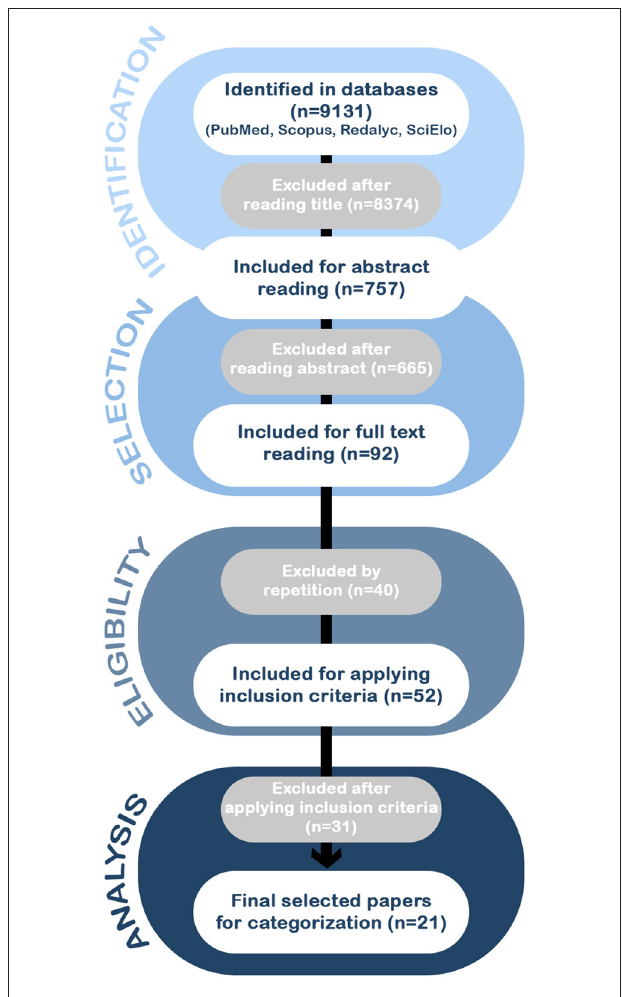
FIGURE 1 | The flow of information through the different phases of the systematic review according to the PRISMA statement. The search of PubMed, Scopus, Redalyc, and SciElo databases provided a total of 9,131 citations. Of these, 8,374 studies were discarded after reviewing the titles, and of those, 665 abstracts did not clearly meet the criteria. After adjusting for duplicates 52 of the 92 articles remained. The full text of the remaining 52 citations was examined in more detail. It appeared that 31 studies did not meet the inclusion criteria as described. No unpublished relevant studies were obtained, achieving a selection of a total of 21 articles for the